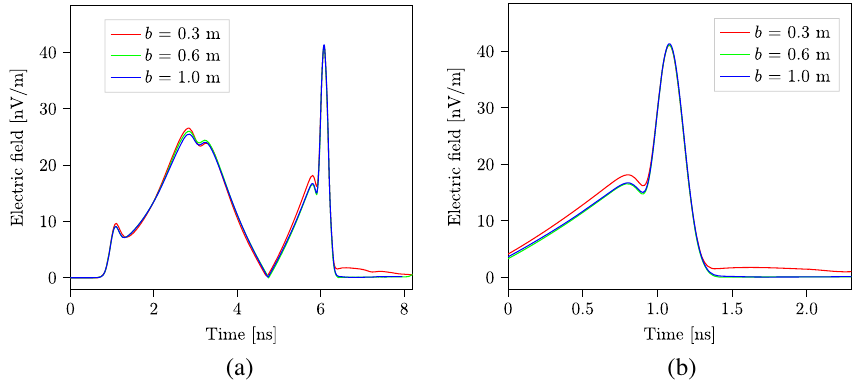
FIG. 13. (a) Obtained radiation (absolute values of E field) as a function of target size for β ¼ 0 . 6 at monitor distance R ¼ 0 . 4 m at 45 degrees. (b) Selected region to highlight the differences.